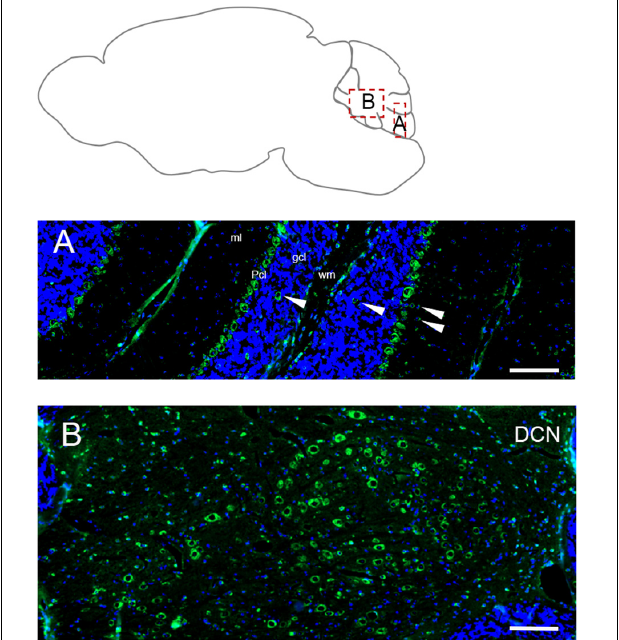
FIGURE 6 | Distribution of Elovl5 in the cerebellum. (A) High magnification of the cerebellar cortex. Purkinje cells (Pcl) strongly express Elovl5; a moderate signal is present in sparse positive cells in white matter (wm), deeper part of the molecular layer (ml) and granular layer (gcl) (white arrow). (B) Prominent expression of Elovl5 (green) (DAPI in blue) by deep cerebellar nuclei (DCN). Scale bars: (A,B) 100 µ